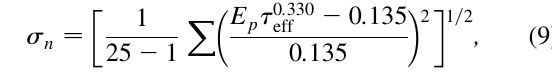
TABLE II. For each of the water-breakdown relations given as Eqs. (5)–(8), we present here the normalized standard deviation (cid:3) of the differences between the measurements listed in Table I n and the associated predictions of the relation. For the first as indicated by Eq. (9). We define (cid:3) relation, we define (cid:3) n for each of the other relations in a similar manner.